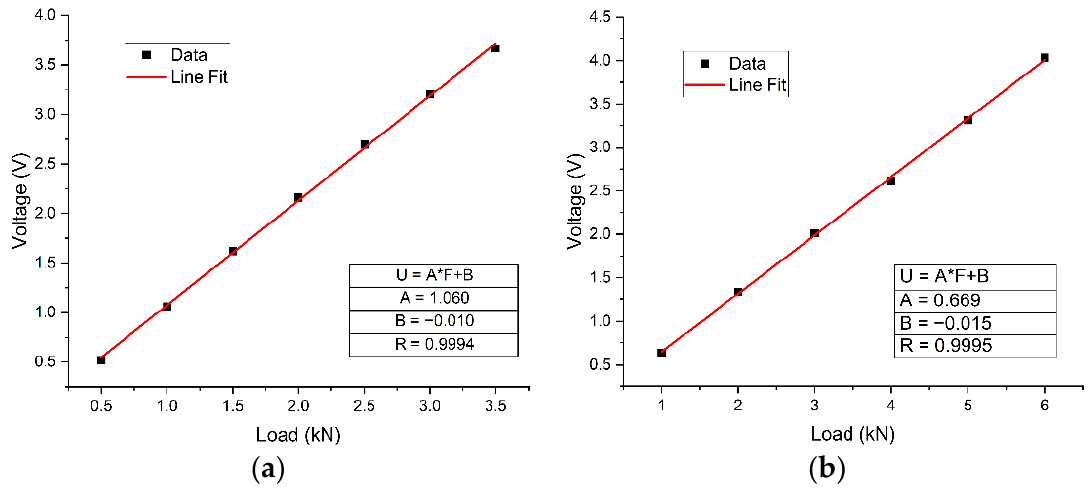
Figure 6. Calibration results of load sensors: ( a ) single shearing case and ( b ) double shearing case. In order to measure the variation of pin-load distribution ratio of fasteners with the applied load, the pin-loads were acquired under different external loads between 3 kN and 12 kN. There are three kinds of fit for the bolted joints, as shown in Figure 7. The experimental joints in this study were not clearance fit. The diameter of the bolt was 4.76 mm, which was slightly larger than the diameter of the hole. Therefore, there was no clearance between the bolt and the hole. It should be interesting to extend related research to the joints with different degrees of clearance fit, which is plan for our future work.